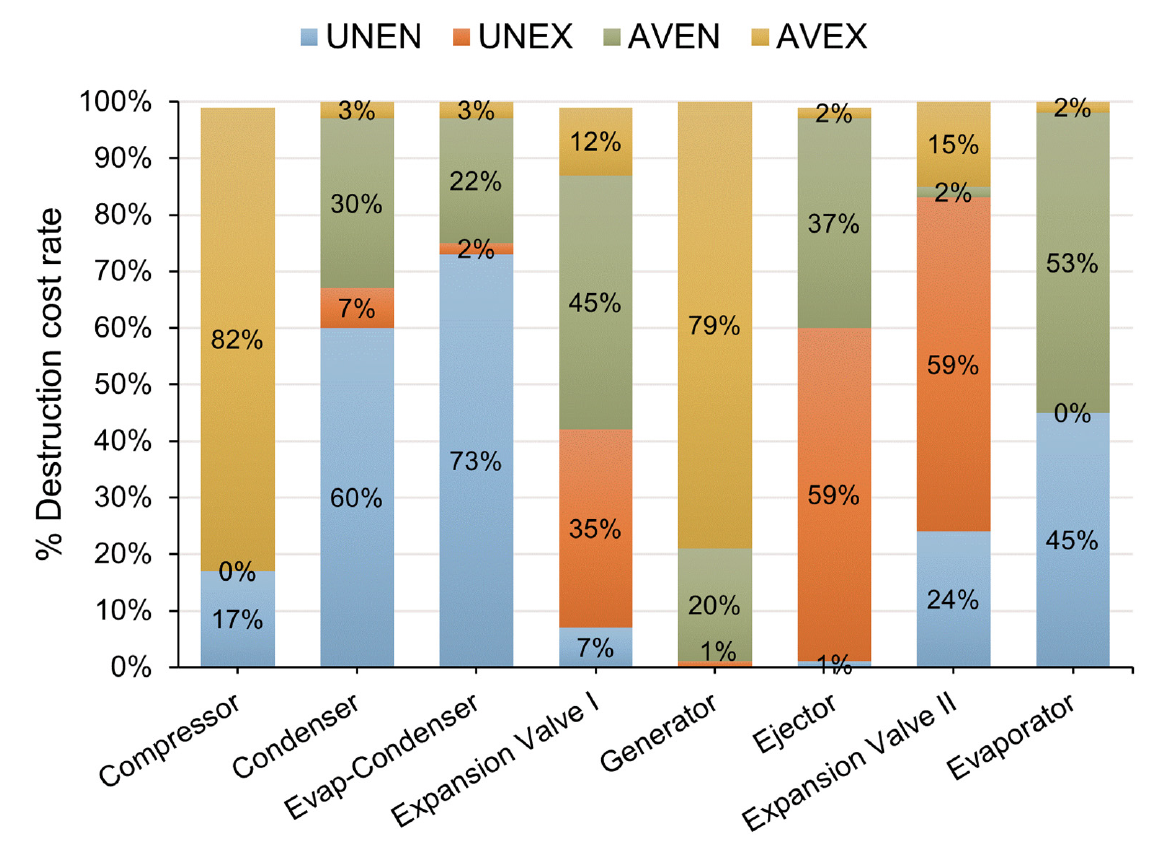
Figure 12. Breakdown of percentage advanced exergy destruction cost rate of the main components.